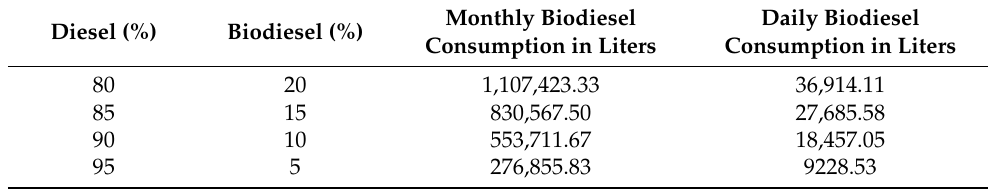
Table 3. Estimate of diesel and biodiesel consumption.